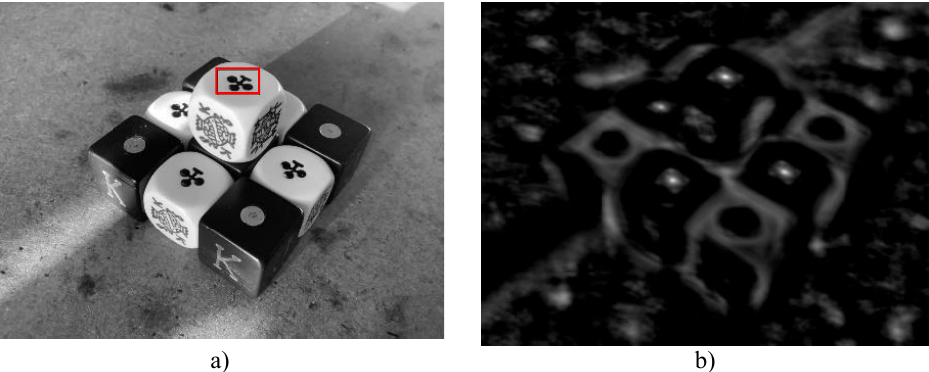
Figure 8. Visualization of the results of the calibration test. ( a ) A grayscale image with an instance of an ace of clover (object of interest) contained within a red bounding box. ( b ) A graphical represen- tation of ZNCC values, with brighter spots representing the spatial location of the highest ZNCC values where similar objects are